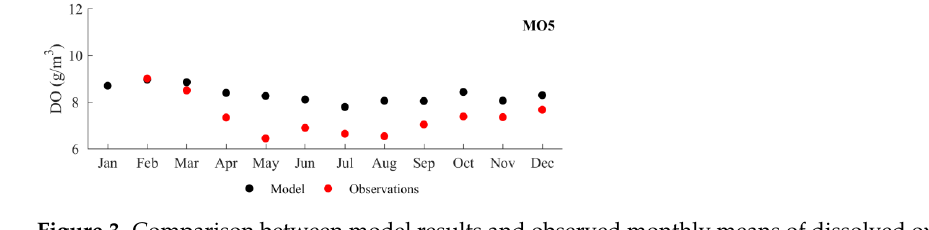
Figure 3. Comparison between model results and observed monthly means of dissolved oxygen for MO5 station located at Mondego Estuary.